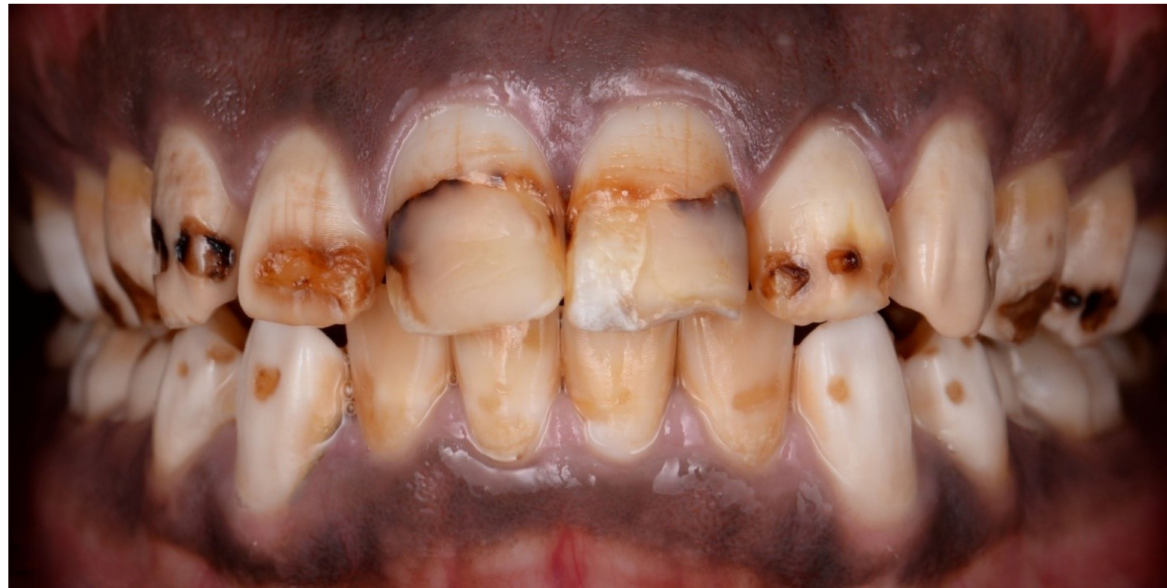
Figure 6. Patient’s dentition after maxillary crown lengthening procedures.